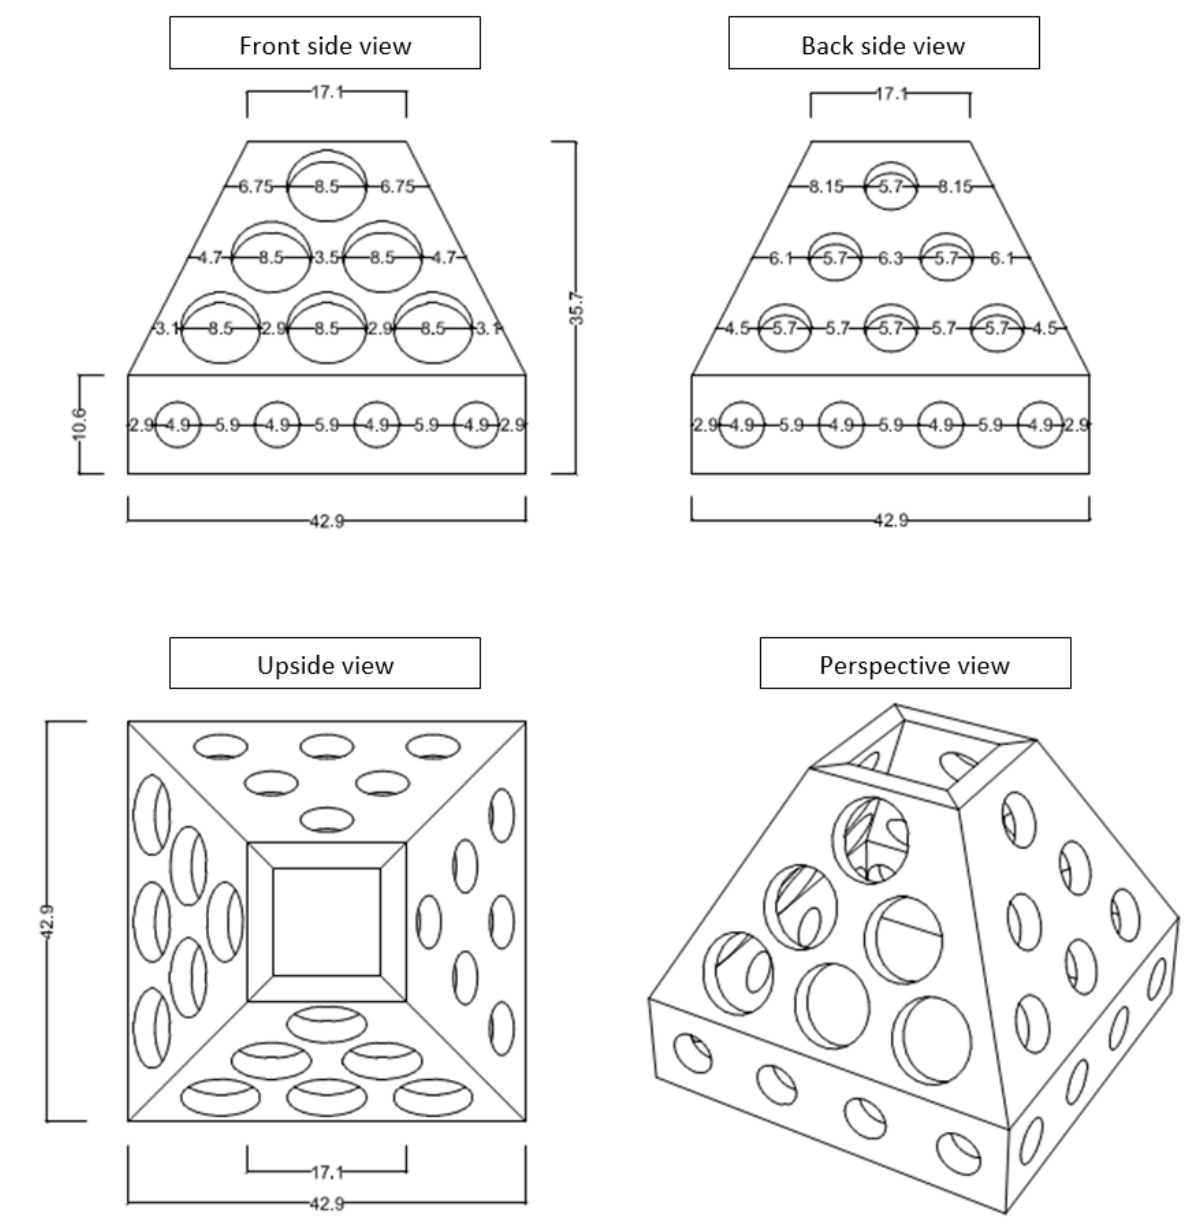
Figure 6. Size of the prototype PTPBW block (unit: cm).